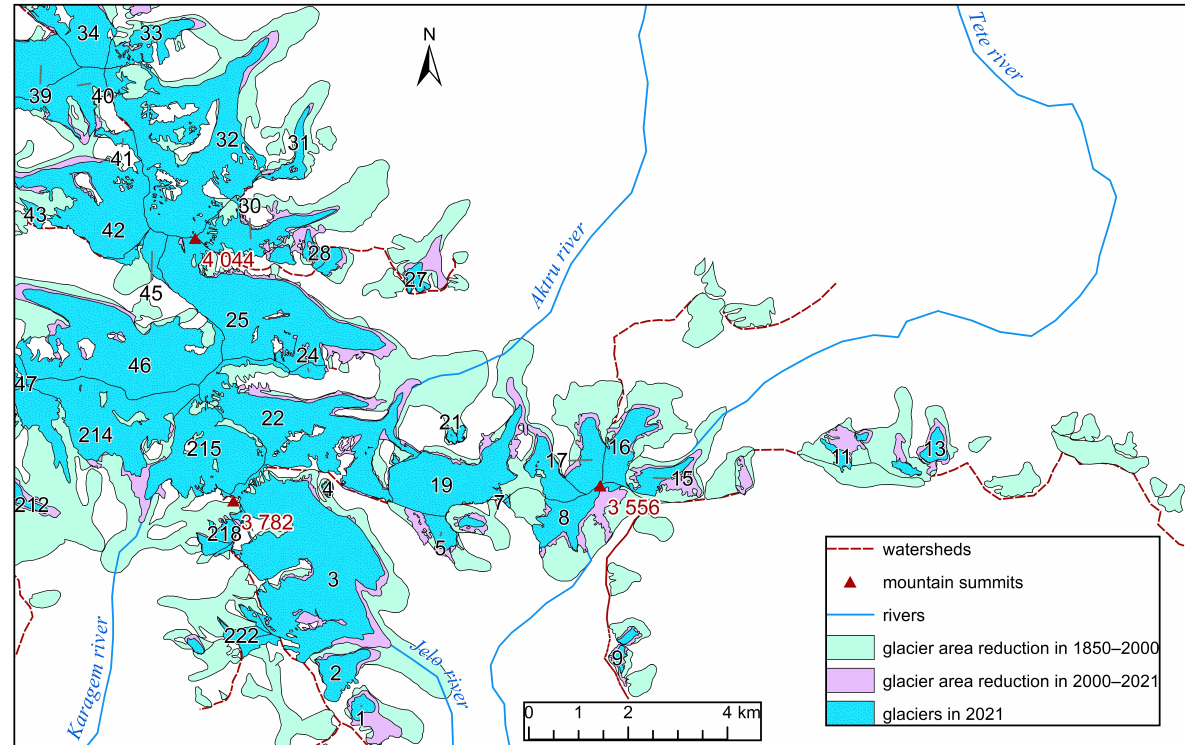
Figure 6. Reduction of the glaciers of the eastern part of the North-Chuya range, the basins of Jelo, Tete, and Aktru rivers, after the LIA